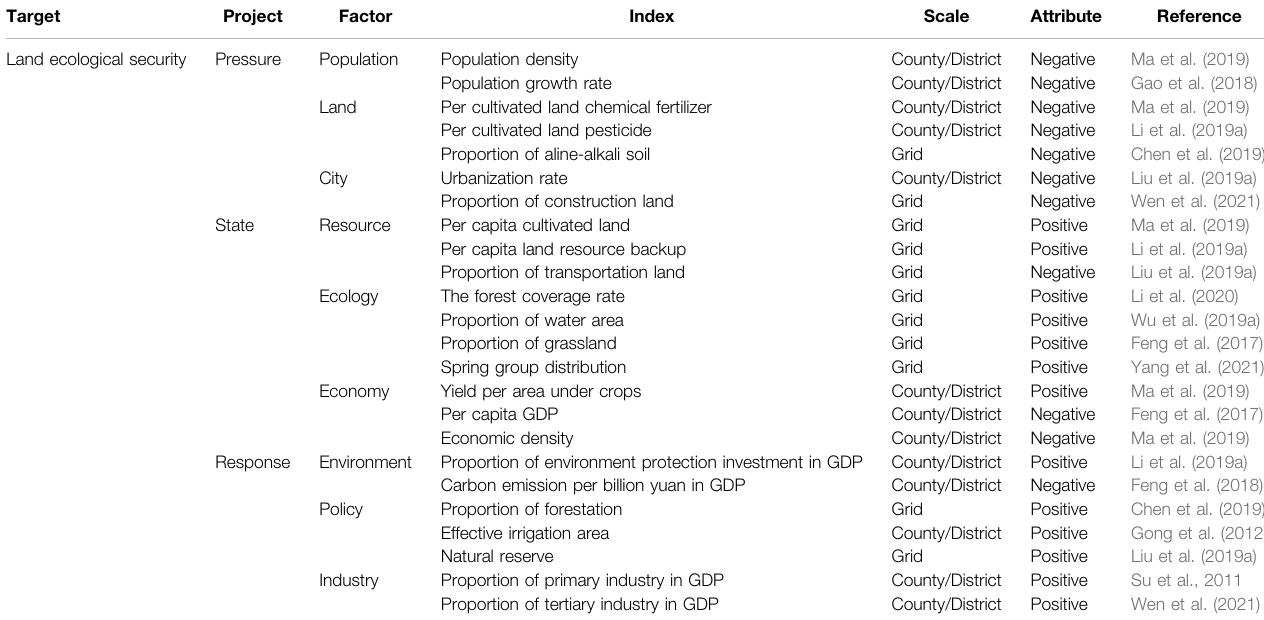
TABLE 1 | Land ecological security assessment indexes in